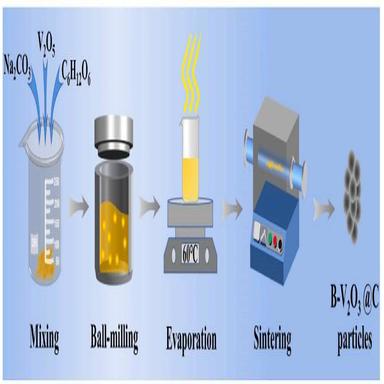
Schematic illustration of the synthesis process of B–V2O3@C.